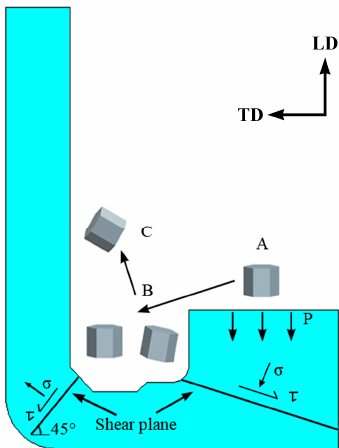
Figure 9. Schematic diagram of the crystal preferred orientation in the present deformation process.